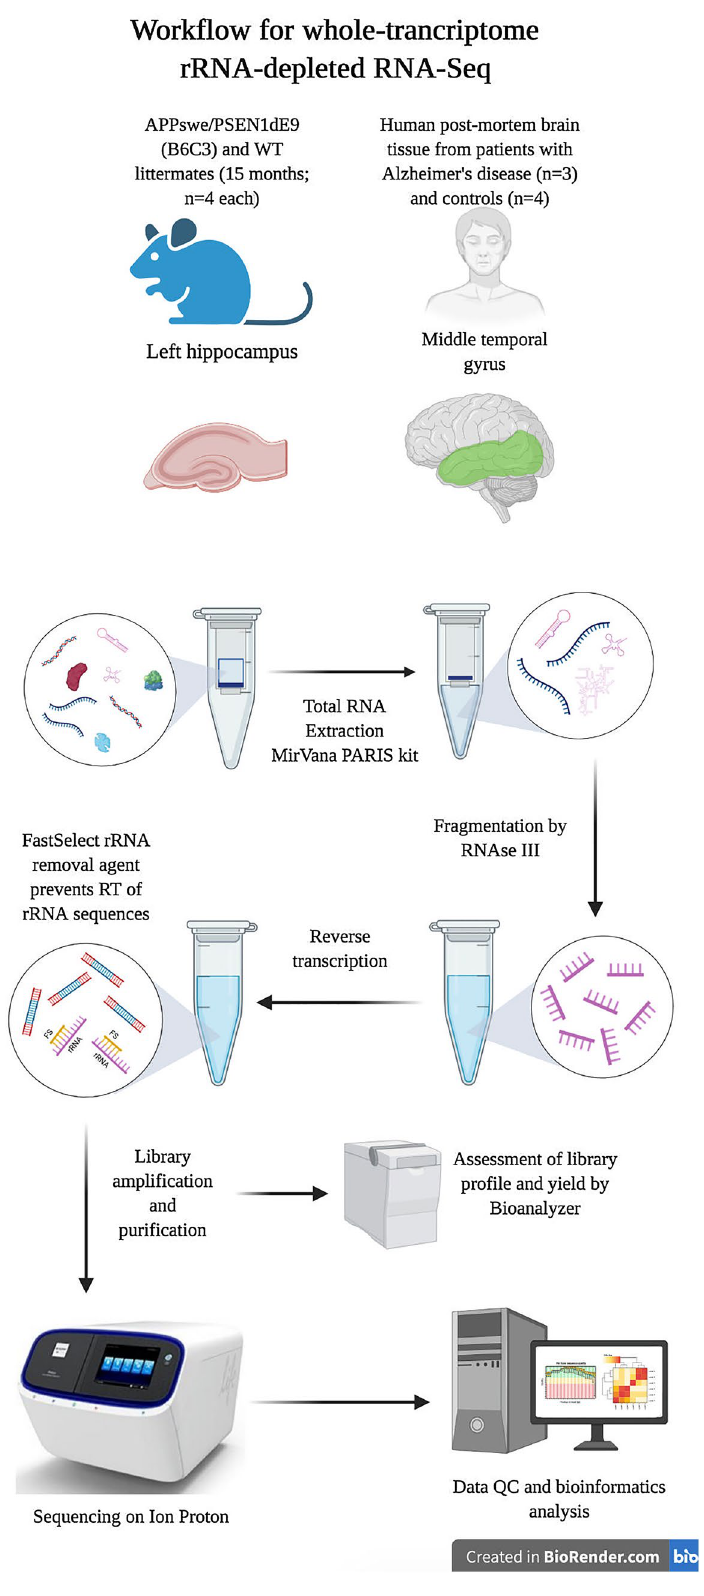
Figure 1. An overview of the protocol described here for simultaneous detection of coding and non-coding RNA by RNA-Seq. Created in